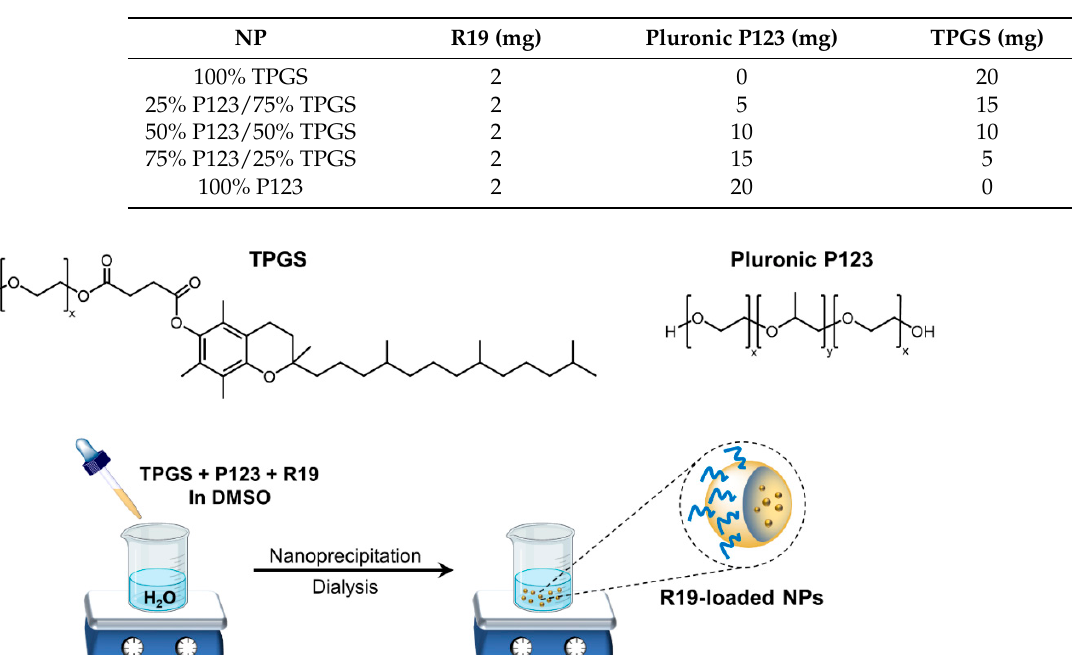
Table 1. Composition of R19-loaded NPs.